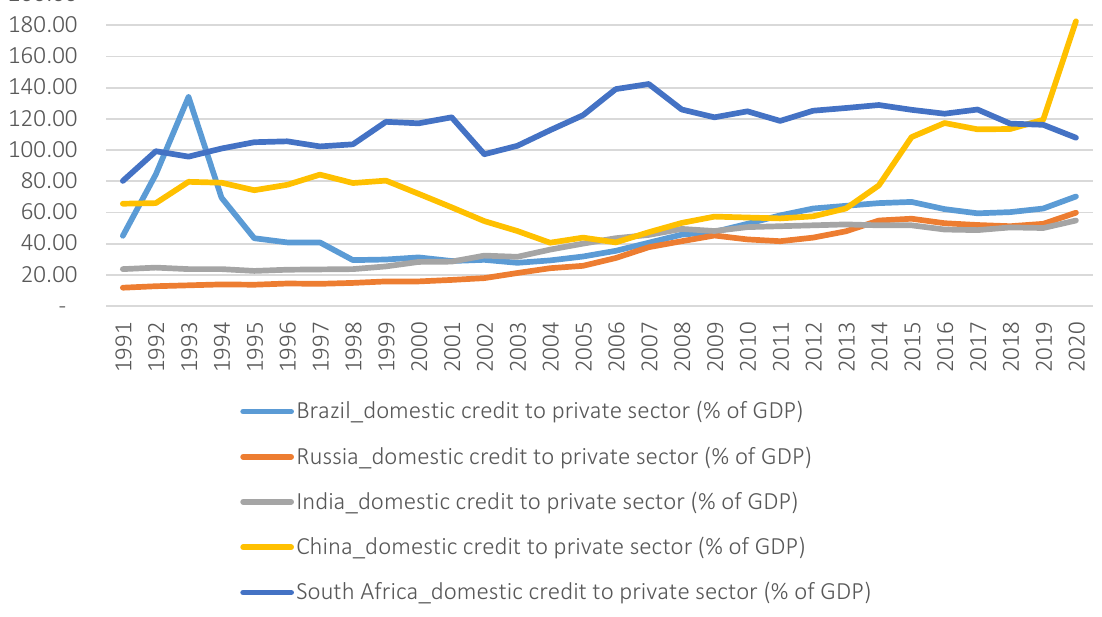
Figure 1. Domestic credit to private sector (% of GDP) trends in